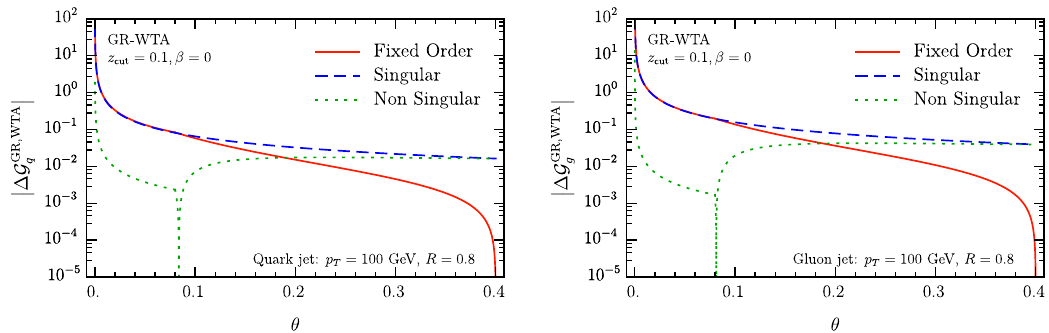
GR ; WTA (red solid), G